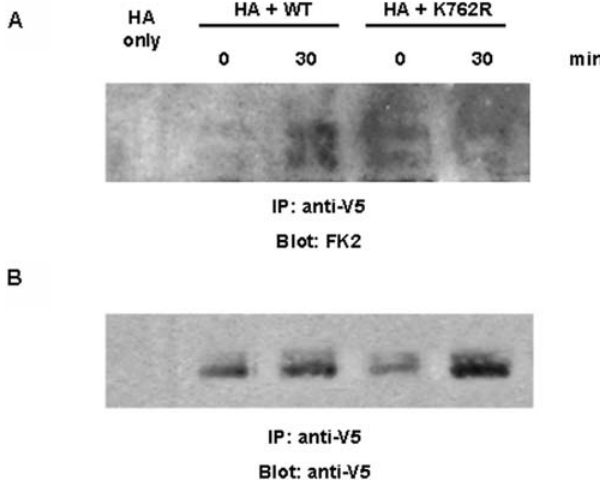
Figure 1. Impaired mono-/polyubiquitination of the K762R/G- CSFR in response to ligand binding. CHO ts20 cells were transiently transfected with HA-tagged ubiquitin alone (HA only), HA- Ubiquitin plus WT G-CSFR (HA + WT), or HA-Ubiquitin plus K762R/G-CSFR (HA + K762R). At 48 hrs after transfection, cells were washed and incubated in serum-free media at 4 u C for 4 hrs before being transferred to 37 u C and incubated with G-CSF (100 ng/mL) for the indicated times. Cells were then lysed, immunoprecipitated with anti-V5 antibody, and blotted with (A) the FK2 antibody which recognizes both poly- and monoubiquitinated proteins. (B) The blot in (A) was stripped and re- blotted with anti-V5 antibody as a control for receptor protein loading.